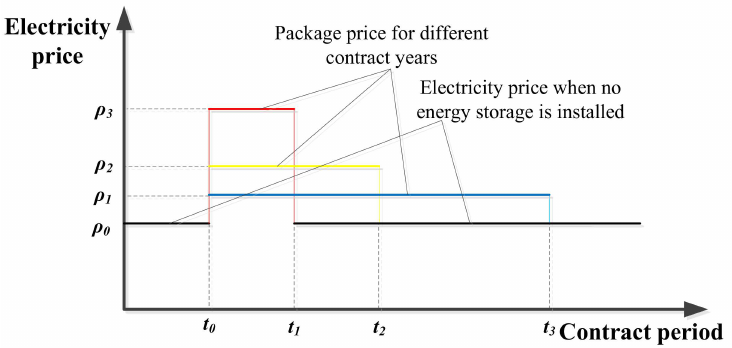
Figure 3. Schematic diagram of electricity supply price for di ff erent contract